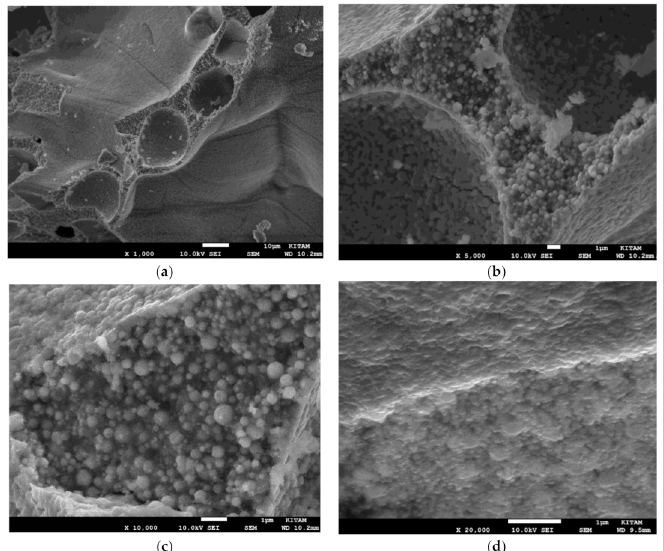
Figure 24. SEM images of Mn / Si = 1 catalyst showing the surface and pore wall structures at various magnifications. ( a ) Overall surface and wall structure; ( b ) Pore and wall structure; ( c ) Surface and wall structures; ( d ) Surface with fused particles and wall structures at higher magnification. Scale bar = 10 µ m ( a ) and Scale bar = 1 µ m ( b – d